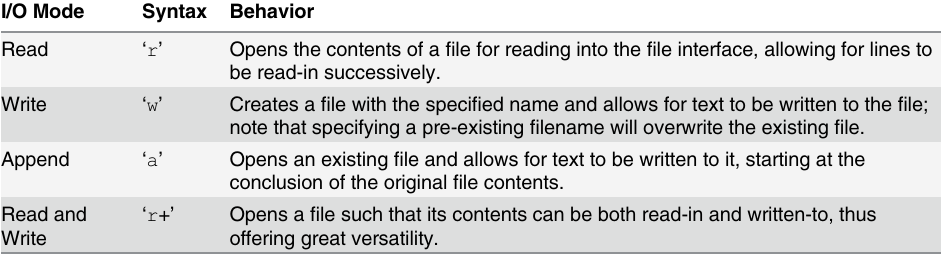
Table 4. Python ’ s file-access